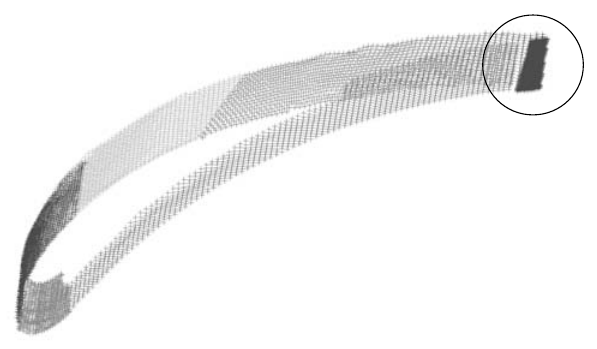
Fig 2. Photogrammetrically obtained wing section surface point cloud (different colours showing section obtained from different mathematic models) with point cloud gap